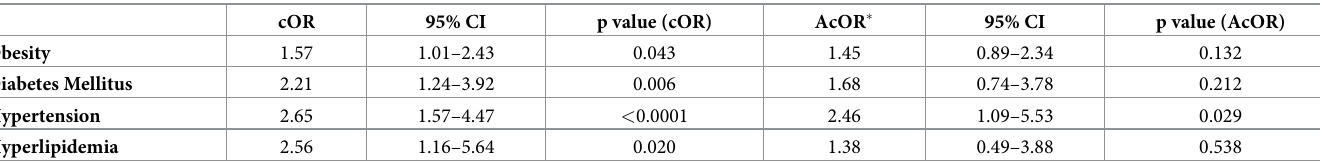
Table 2. Conditional odds ratio (cOR) and adjusted conditional odds ratio (AcOR) for the association between comorbidities and severe